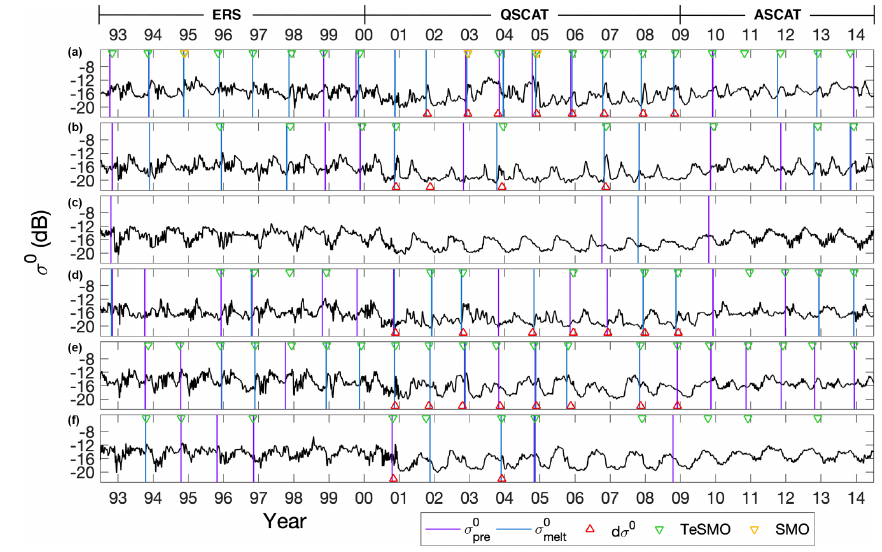
Figure 3. As Fig. 2 but for study sites on seasonal sea ice (Fig. 1, A–F).